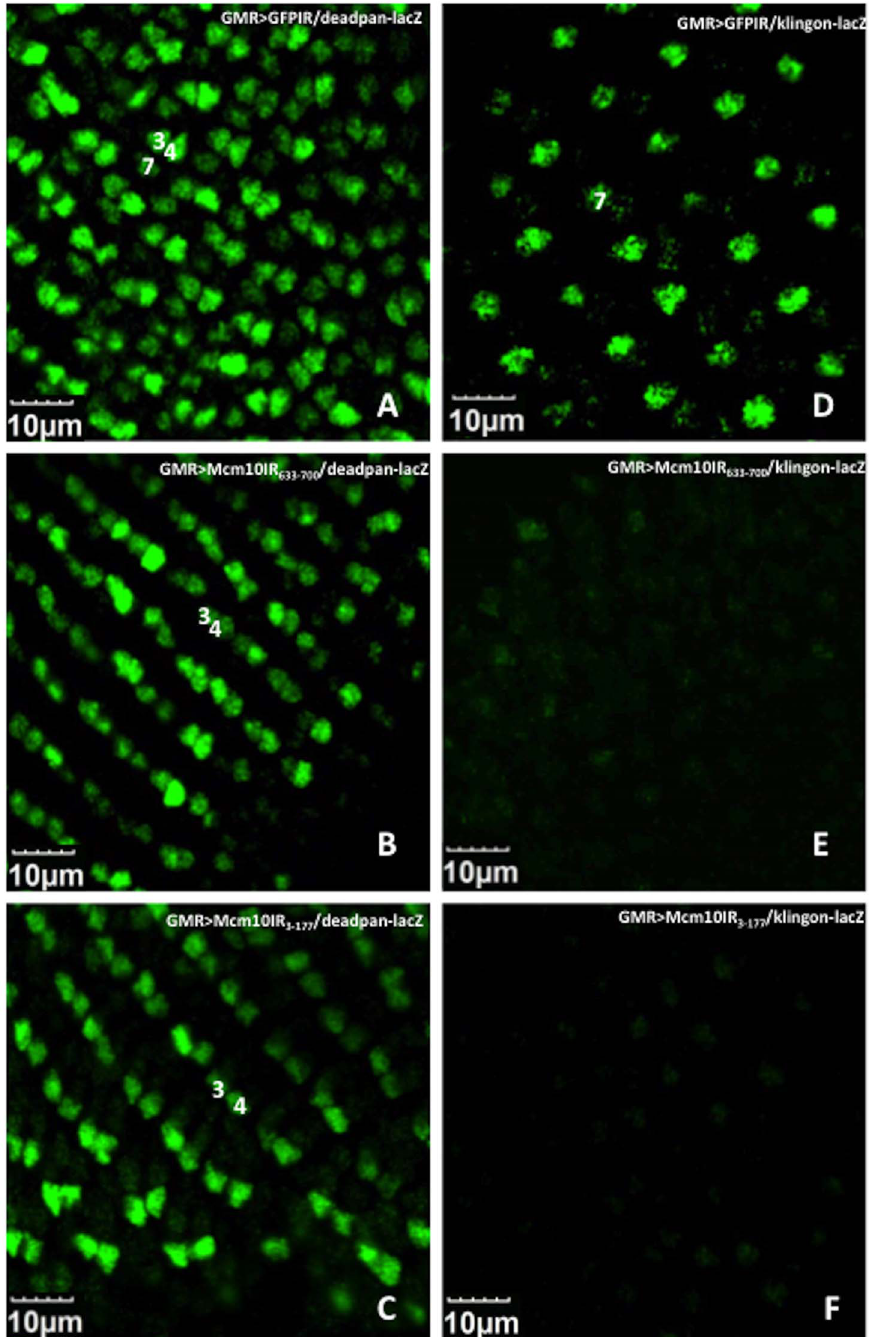
Figure 9. Effect of dMcm10 knockdown on photoreceptor cells monitored by two enhancer trap lines. Immunostaining of eye discs with anti-lacZ antibodies (Green) (A) GMR -GAL4/ + ; deadpan-lacZ/ + ; UAS- GFPIR / + ; (B) GMR -GAL4/ + ; deadpan-lacZ/ + ; UAS-d Mcm10IR 633-700 / + ; (C) GMR -GAL4/ + ; deadpan-lacZ/UAS-d Mcm10IR 3-117 , + ; (D) GMR -GAL4/ + ; + ; UAS- GFPIR /klingon-lacZ, (E) GMR -GAL4/ + ; + ; UAS- Mcm10IR 633-700 /klingon-lacZ; (F) GMR - GAL4/ + ; UAS-d Mcm10IR 3-117 / + ; klingon-lacZ/ + . (A–C) R3, R4, and R7 photoreceptor cells are marked by P82 (deadpan-lacZ) and (D–F) R7 photoreceptor cells are marked by B38 (klingon-lacZ). R7 photoreceptor cells were reduced significantly in both of the knockdown lines: dMcm10IR 633-700 (B, E) and dMcm10IR 3-117 (C, F). Bars indicate 10 m m. The flies were reared at 28 u C. doi:10.1371/journal.pone.0093450.g009 flies co-expressing GFP (Figure 8C and G). Taken together, these Knockdown of dMcm10 affects the differentiation of the observations provide further evidence for an important role for R7 photoreceptor cell dMcm10 in genomic stability. Immunostaining of eye discs with anti-dMcm10 showed several enhanced dMcm10 signals accumulating in the posterior regions